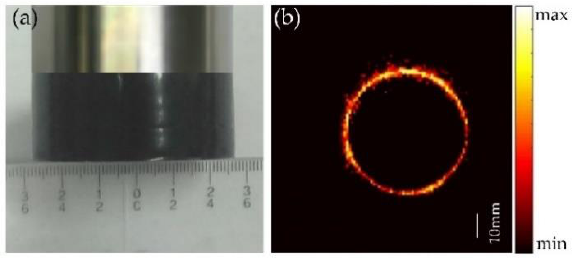
Figure 7. ( a ) Phantom of imaging range test, ( b ) Reconstructed PA image.